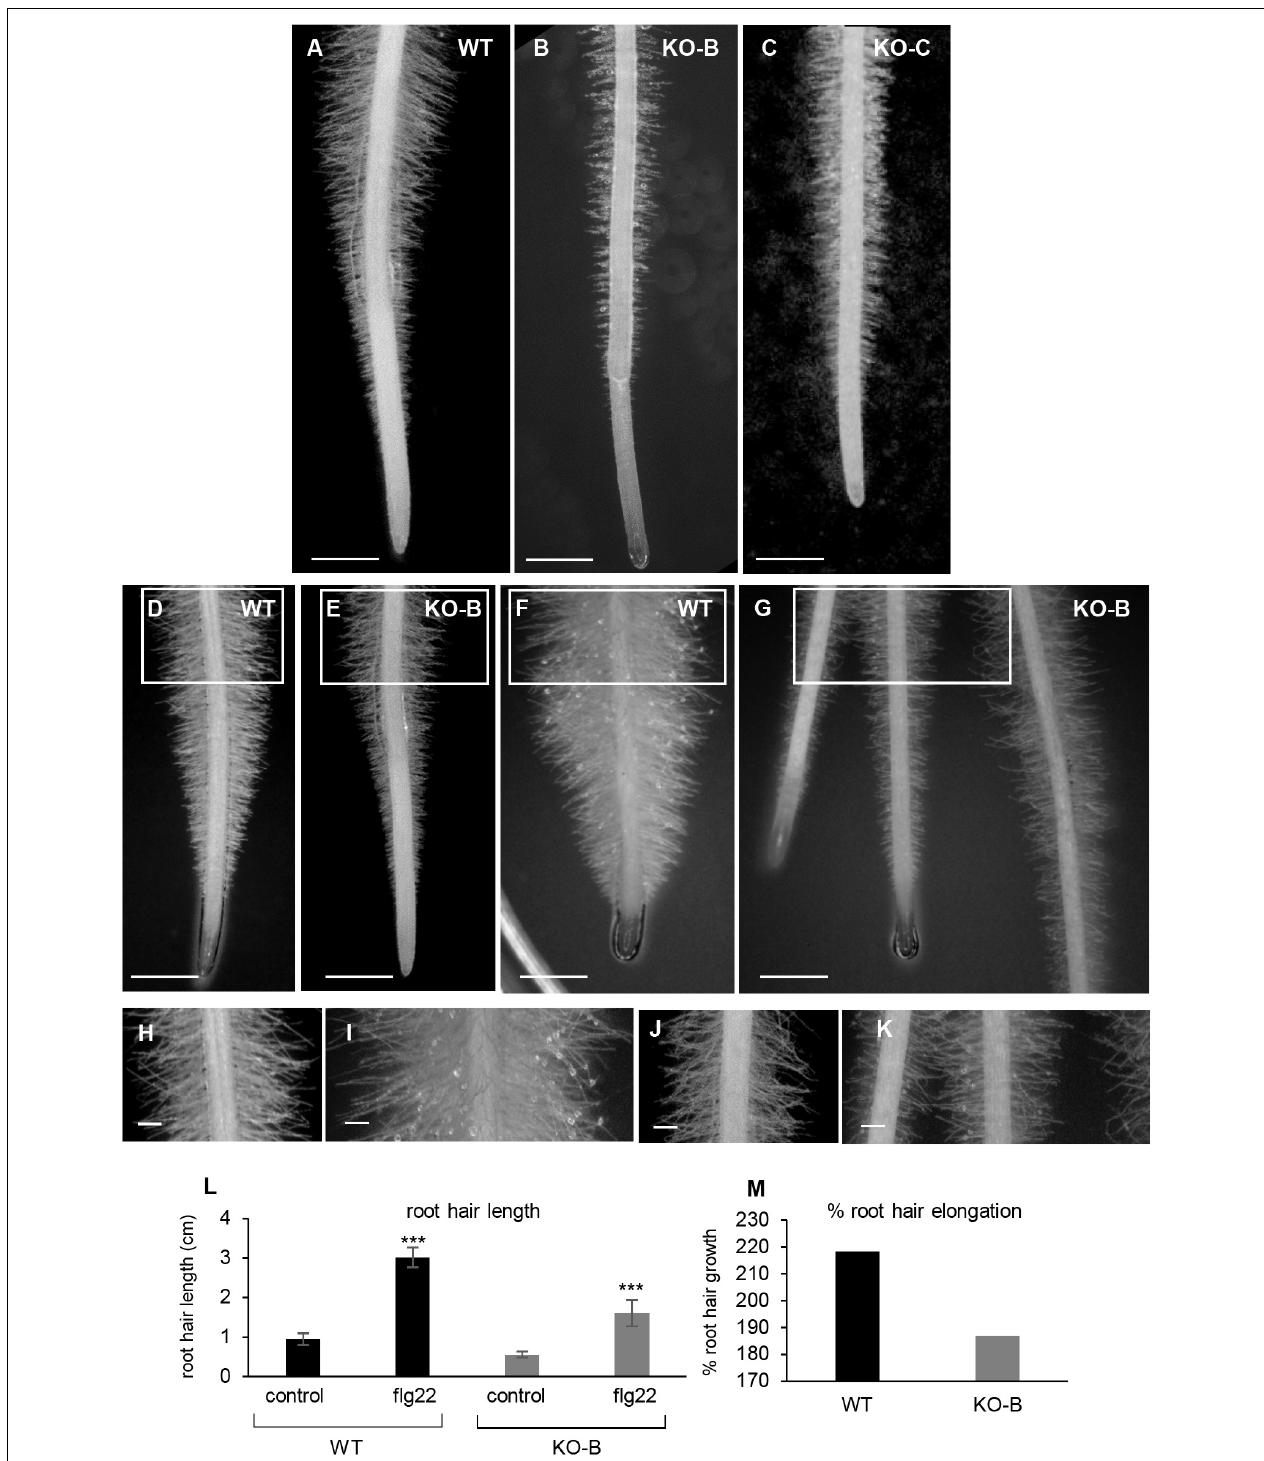
FIGURE 9 | Influence of HvMPK3 knock-out and flg22 treatment on the phenotype of root hairs. (A–C) Comparison views of root apex between wild type [WT; (A) ] and HvMPK3 KO-B (B) and KO-C (C) lines showing decreased root hair elongation. (D–G) Overview of control WT (D,F) and HvMPK3 KO-B (E,G) roots 2 days after the transfer to either control media (D,E) or flg22-containing media (F,G) . Note, that WTs develop dense and highly elongated root hairs compared to HvMPK3 KO roots. (H–K) Higher magnification of the boxed areas of (D–G) showing in detail terminally grown root hairs of control WT and HvMPK3 KO (H,J) and after flg22 treatment (I,K) . (L,M) Quantitative assessment of root hair length (L) and percentage of increased root hair elongation (M) comparing control and flg22-treated WT and HvMPK3 KO seedlings. Scale bars: 2 mm (A–G) , 500 µ m (H–K) ; *** p < 0.001, Student’s t -test.